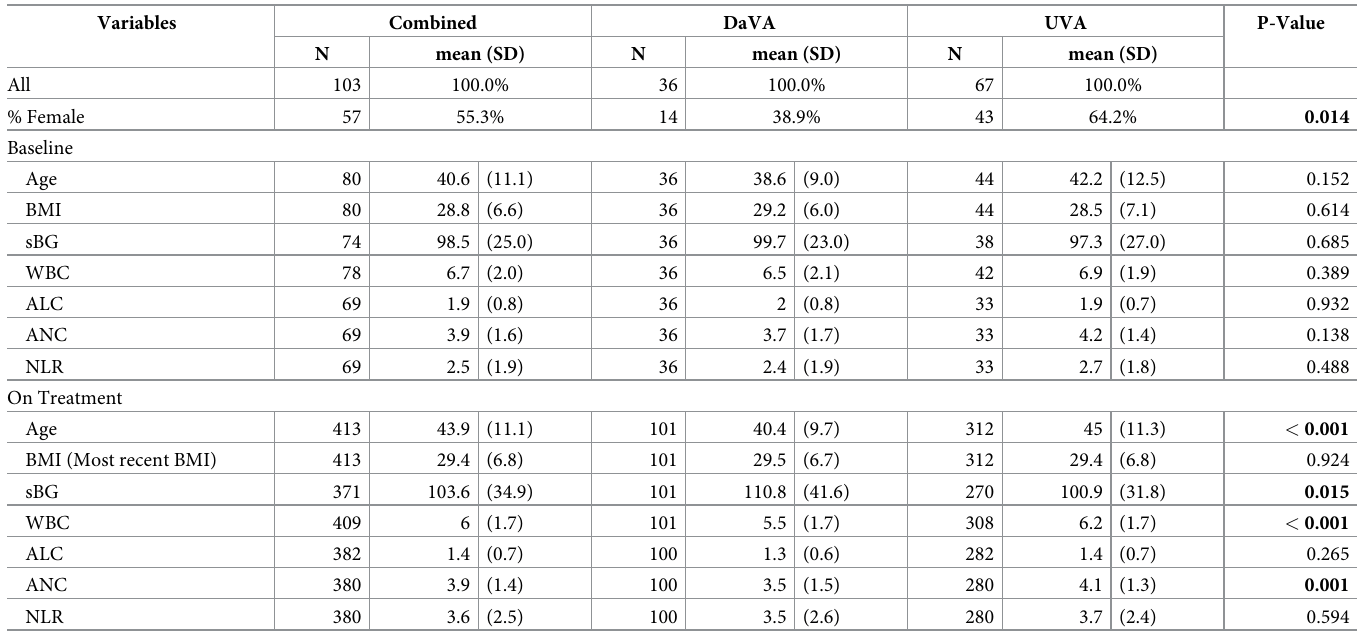
Table 1. Subject demographics and serum blood glucose levels and leukocyte counts � .